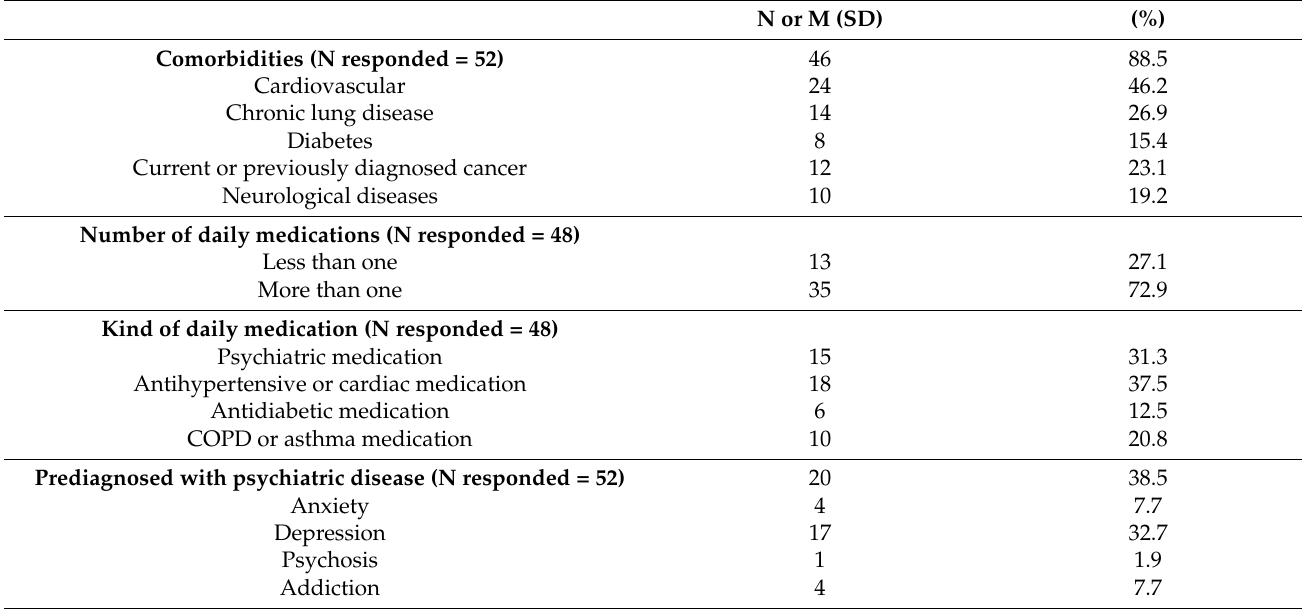
Table 1. Demographic and clinical characteristics assessing medical history and previous psychiatric and psychotherapy treatment and experience. N responded = the number of callers who were willing to answer the question. N represents the number of callers who affirmed the specific information and features asked. The percentage was calculated as (N/N responded) ×